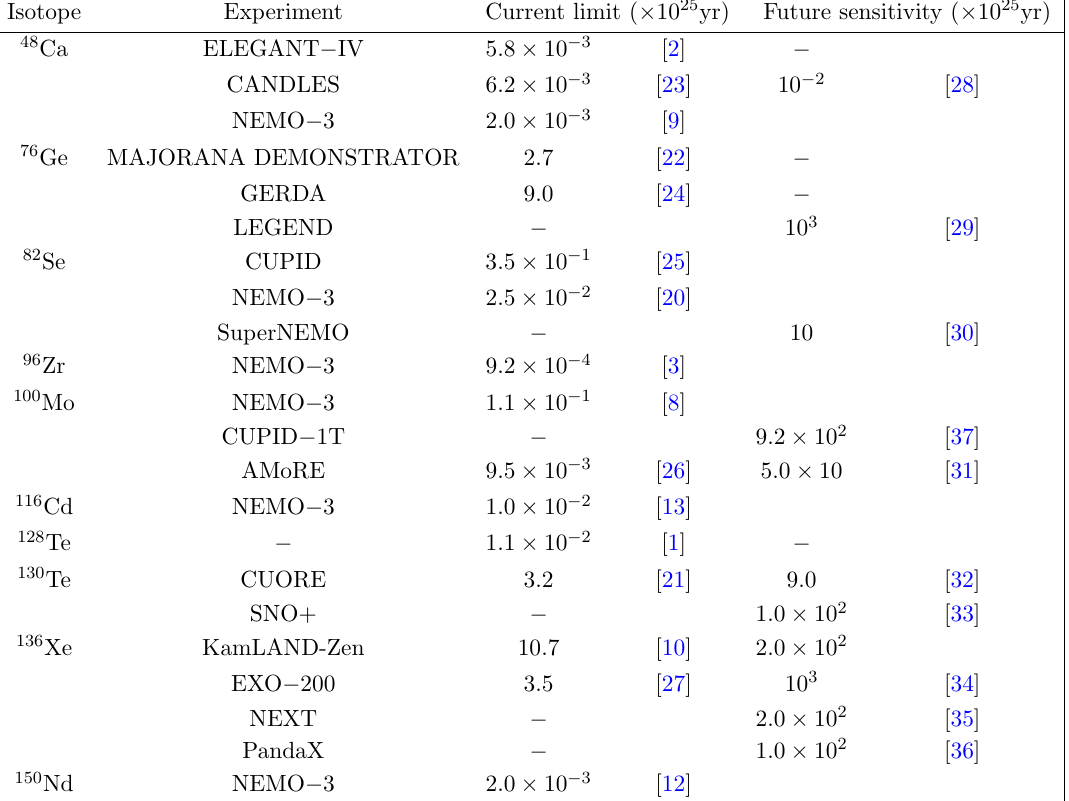
Table 9 . Current and future experimental limits on T 0 (cid:23)